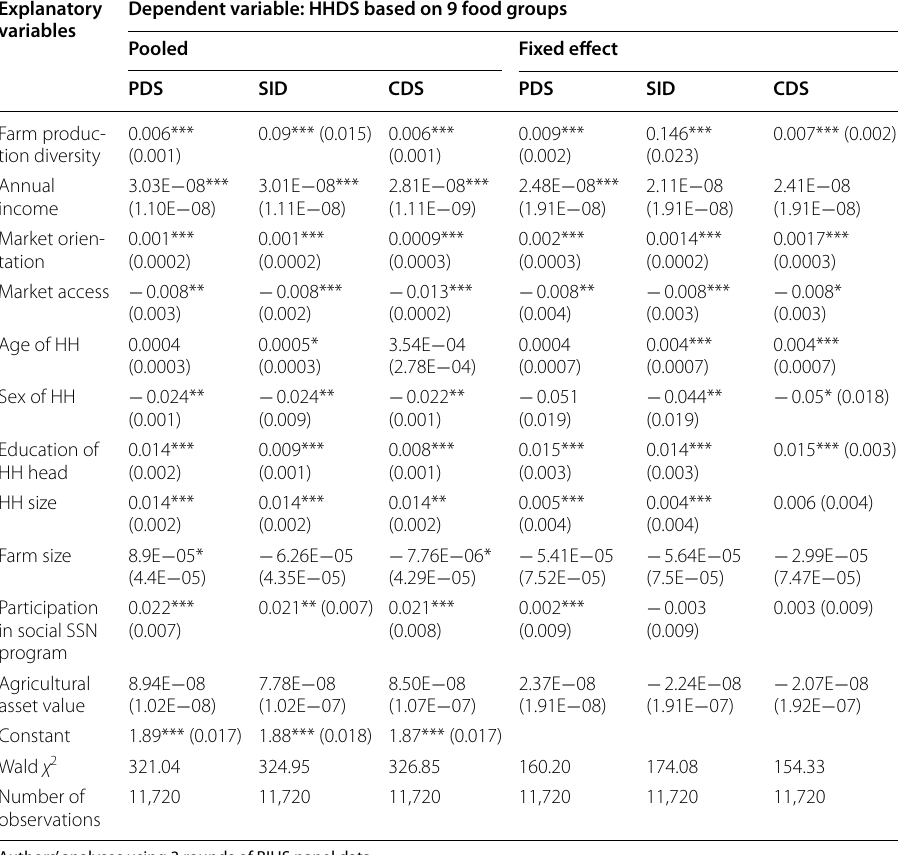
Table 9 Extended model of the association between HHDS (using healthy food groups) and farm production